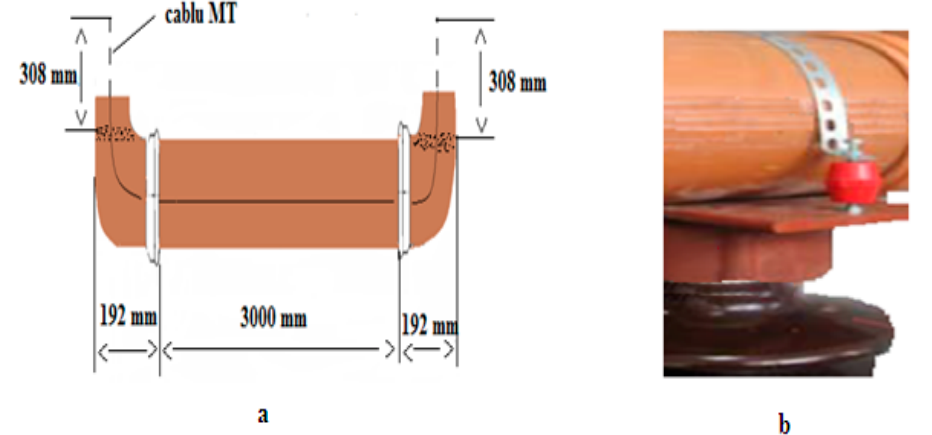
Figure 4. ( a )Assembly of the multilayer PVC pipe, fireproof type SN4-125 × 3.2, PVC elbow type D125 87°; ( b ) Method used for fixing the tube on the IT insulating support.